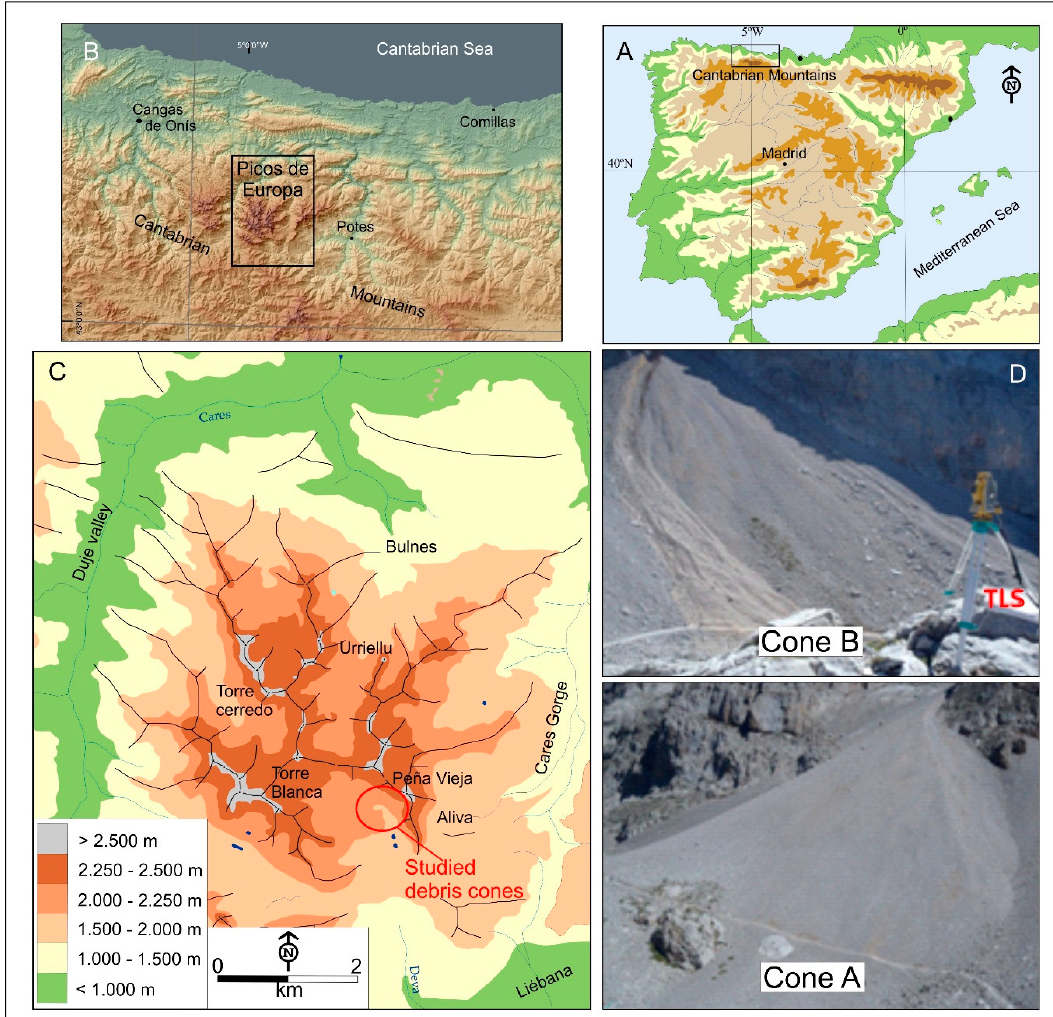
Figure 1. Location of the study area and debris cones: (A) Cantabrian Mountains in the north of Iberian Peninsula. (B) Location of the Picos de Europa massifs. (C) The Central Massif of Picos de Europa and location of debris cones in the south face of Peña Vieja. (D) Detailed photographs of Cone A and Cone B including terrestrial laser scanning (TLS) station.